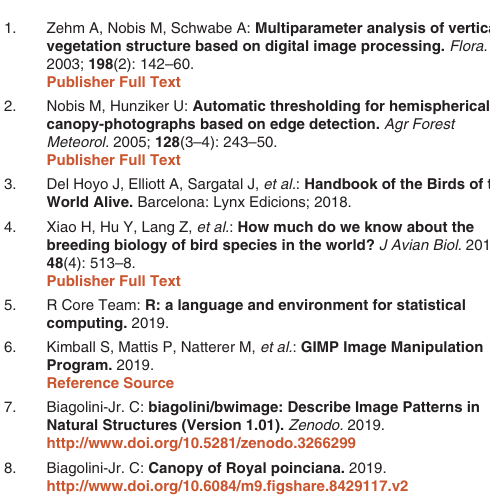
(CC0 1.0 Public domain